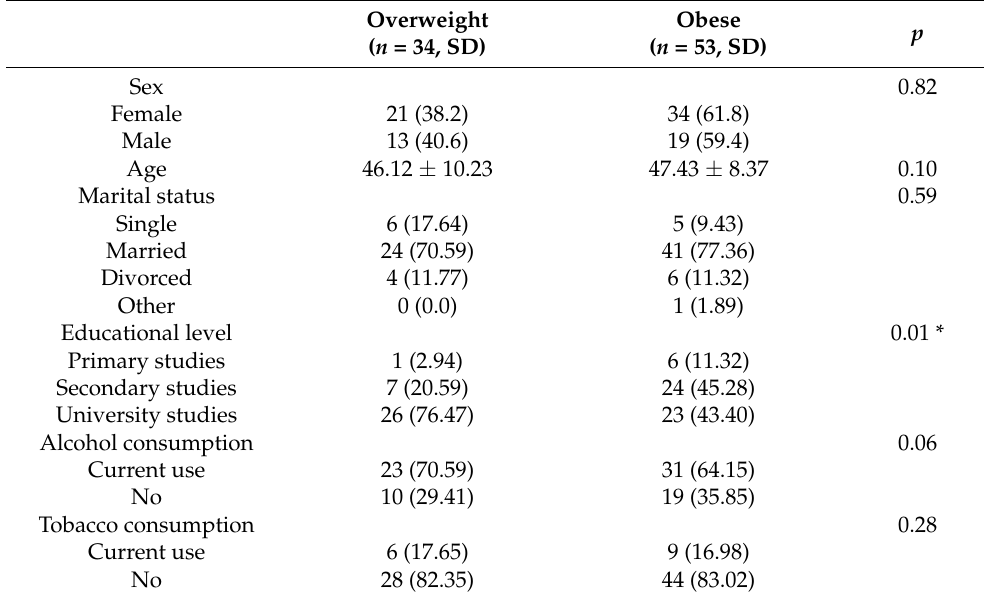
Table 1. Sociodemographic characteristics of participants ( n =